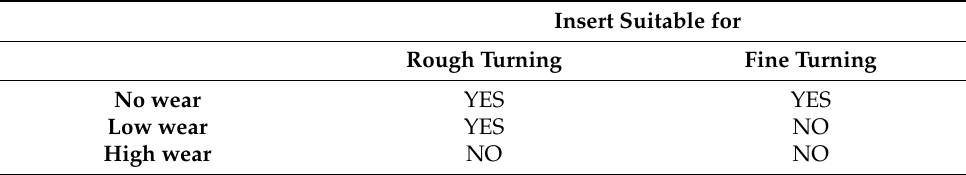
Table 9. Adequacy of the tool according to the machining